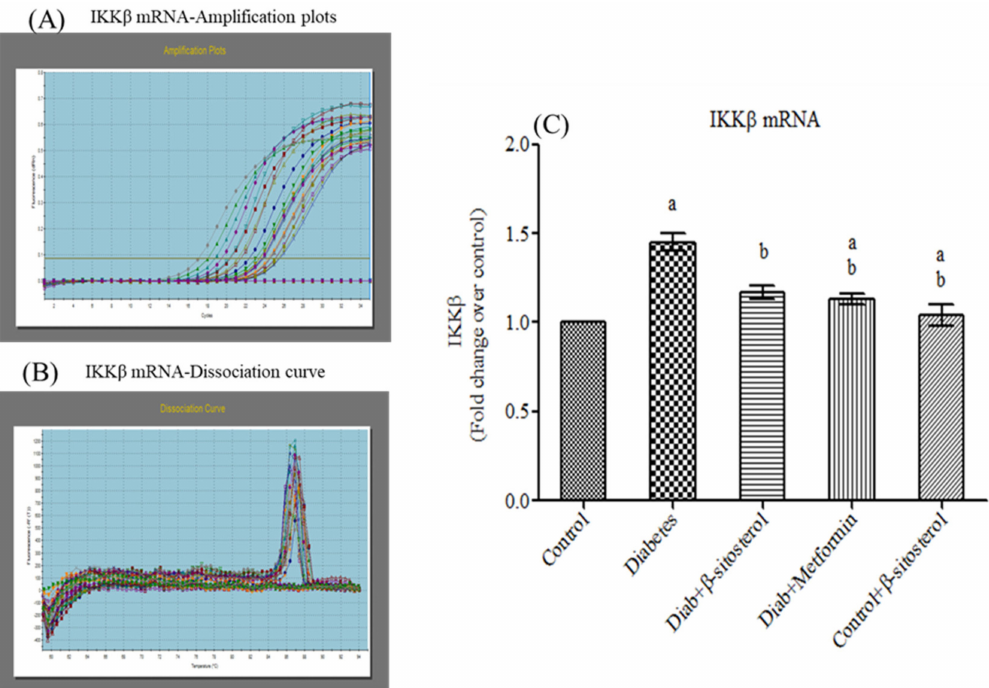
Figure 10. Effect of SIT on mRNA expression of IKK β in adipose tissue of type-2 diabetic rats. The mRNA expression of IKK β was assessed by real time-PCR. ( A ): Amplification plots; ( B ): dissociation curve analysis confirms the single product of IKK β mRNA and ( C ): mRNA expression is given in fold change. Each bar represents mean ± SEM ( n = 6). Significance at p < 0.05. a Significantly different from the control group; b significantly different from the diabetic group.